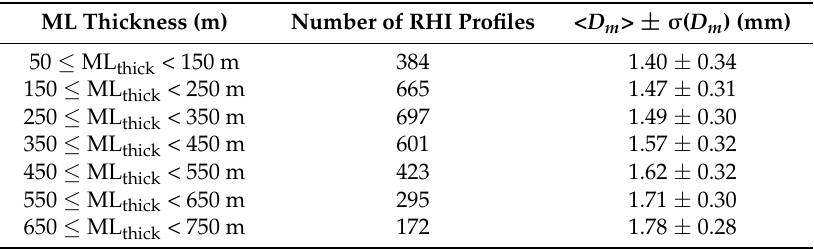
Table 3. Overview of D m retrievals from radar RHI scans during periods of varying ML thickness. The angle brackets represent the arithmetic mean of the retrieved profile and σ is its standard deviation.